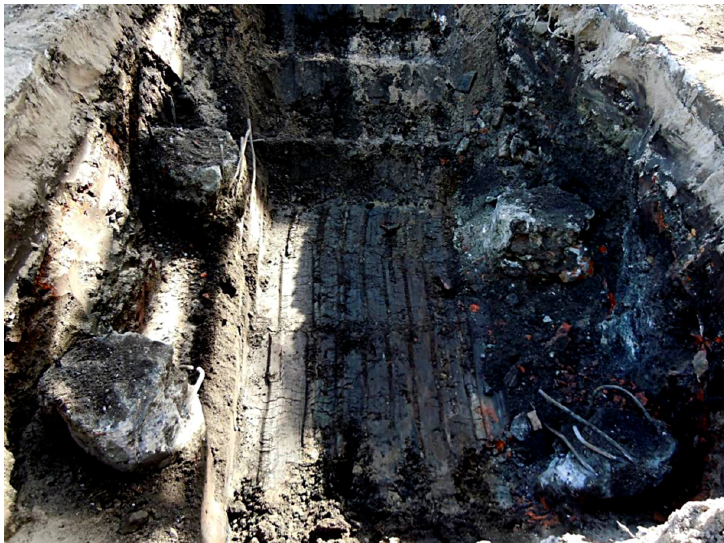
Fig 1. View of corroded column heads (Gdansk) including direct visual information about the process of corrosion.